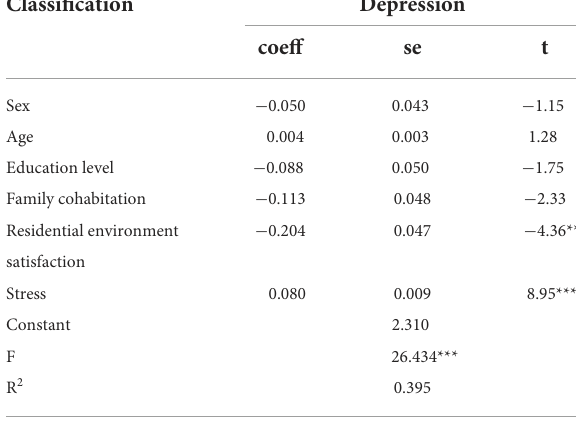
TABLE 4 Relationship between residential environment satisfaction and stress.